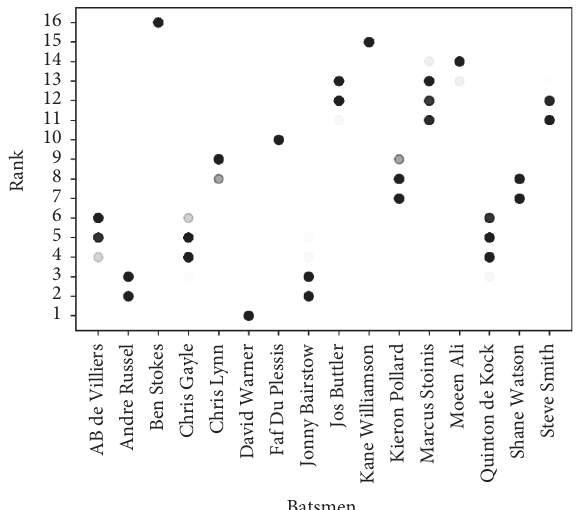
Figure 9: Heat map for batsmen ranks by TODIM through varying θ .